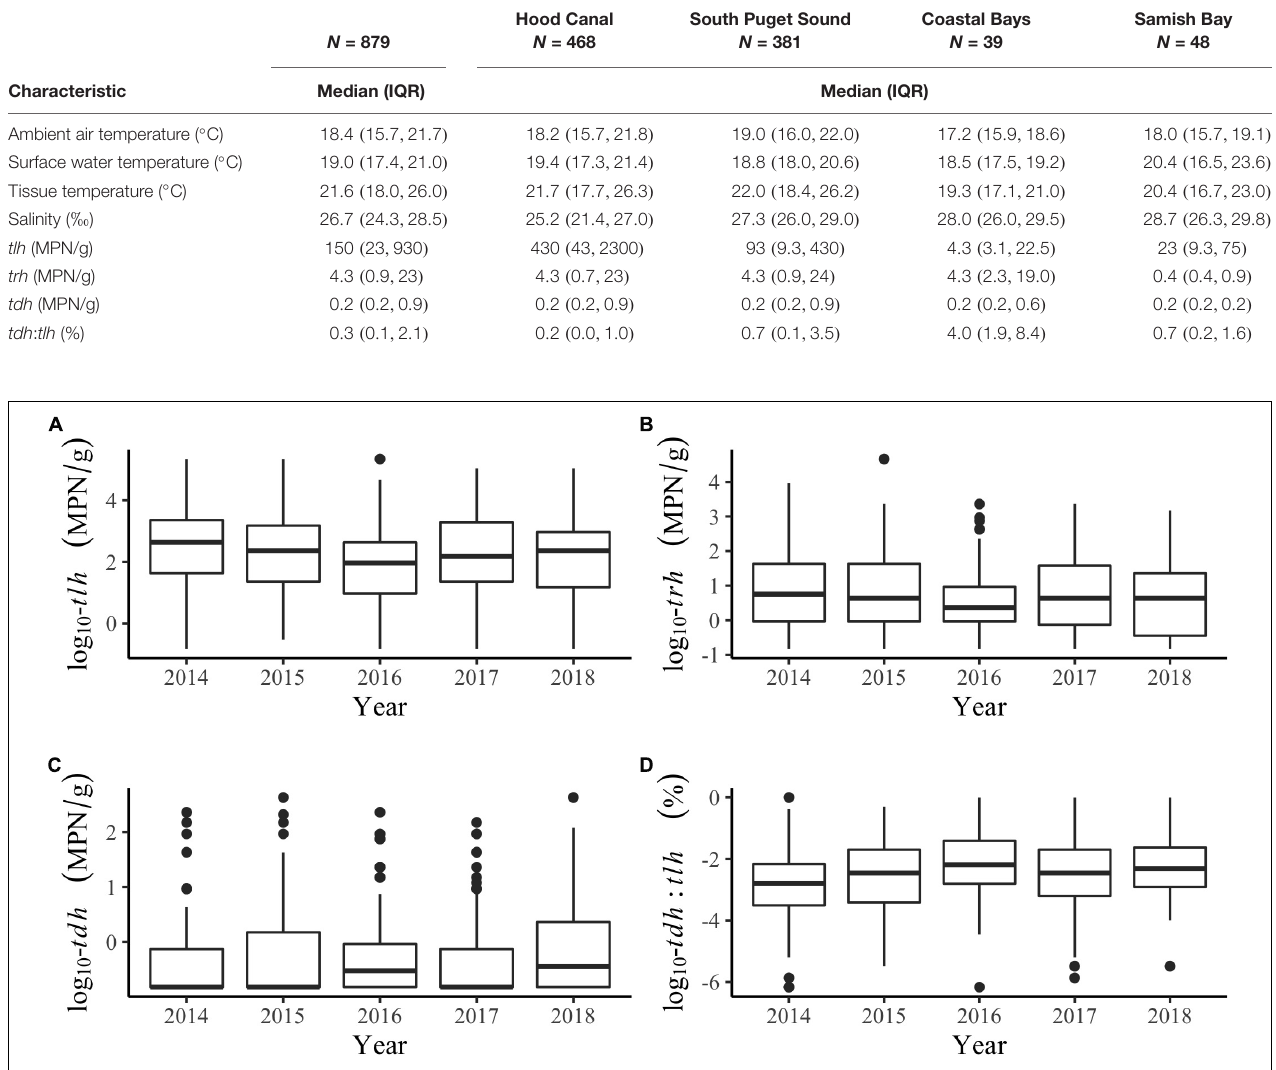
FIGURE 2 | Boxplots of genetic markers by year for (A) tlh , (B) trh , (C) tdh , and (D) the tdh : tlh pathogenic ratio.